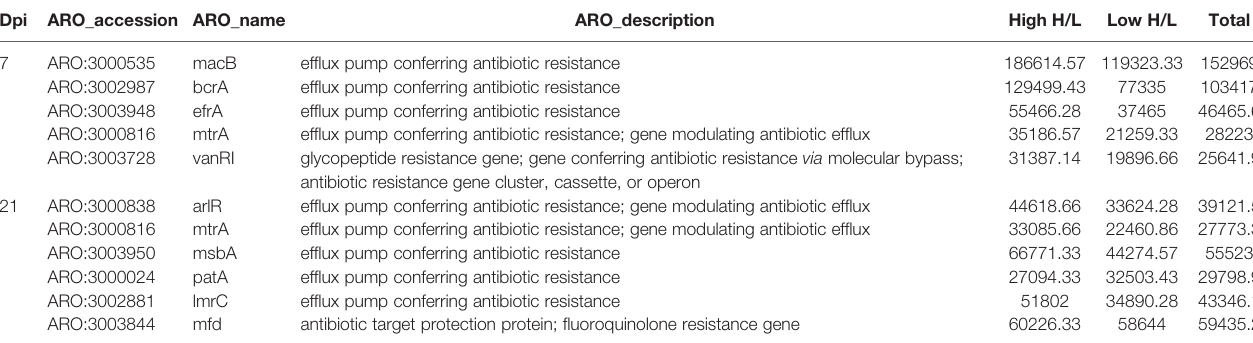
TABLE 3 | Top differentially abundant antibiotic resistance genes between high and low H/L ratio SE-infected chickens based on CARD database annotation.